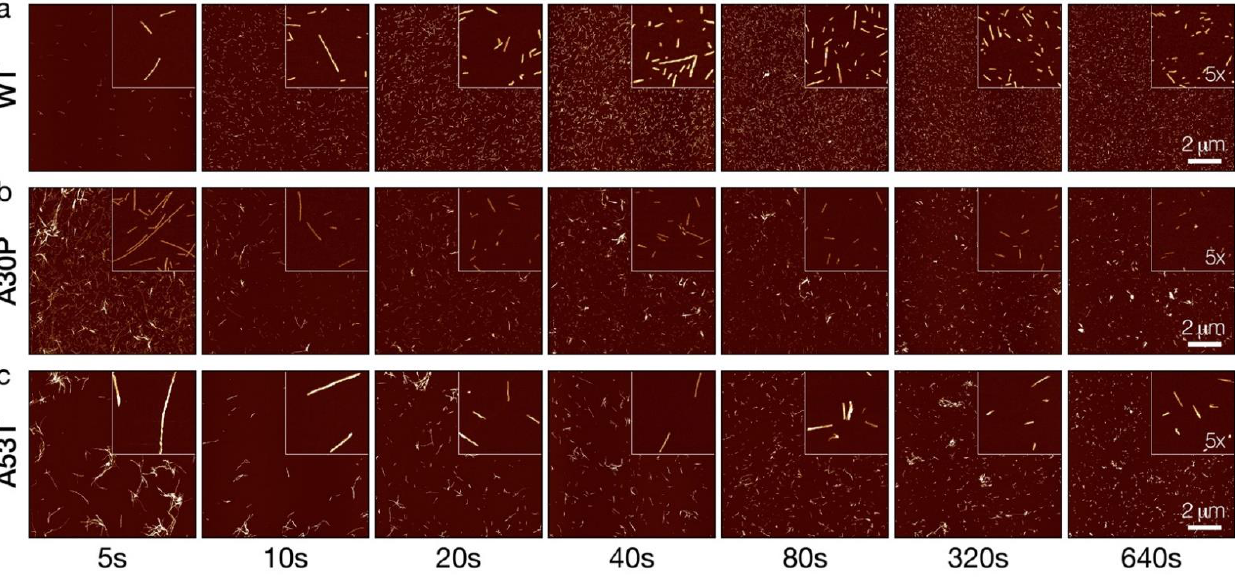
Figure 2. AFM imaging of WT, A30P and A53T α-synuclein amyloid fibrils undergoing fragmentation by controlled sonication. WT ( a ), A30P ( b ) and A53T ( c ) α-synuclein amyloid fibril samples formed from 50 µM monomer equivalent protein concentration were sonicated for up to 640 s, with the duration of sonication indicated for each time-point sample. AFM images representing 10 × 10 µm surface areas are shown with insets of 5× magnified images. The scale bars indicate 2 µm in all images.